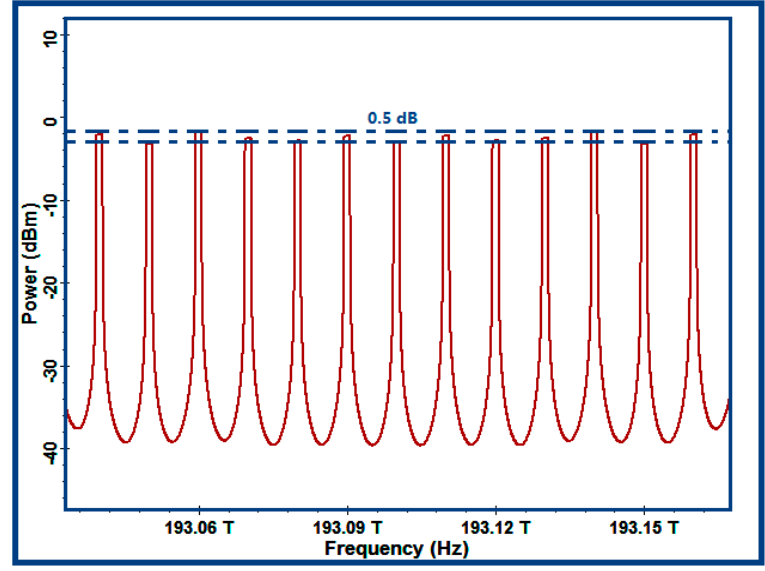
Figure 6. Multi-wavelength optical comb (13 channels).